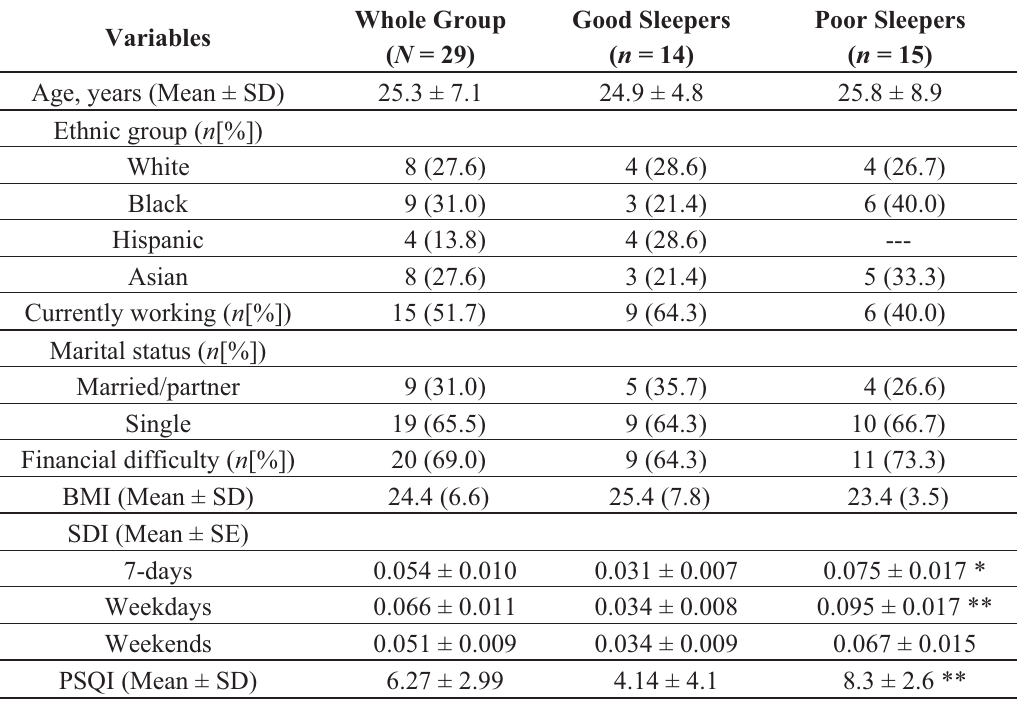
Table 2. Characteristics of the study participants.